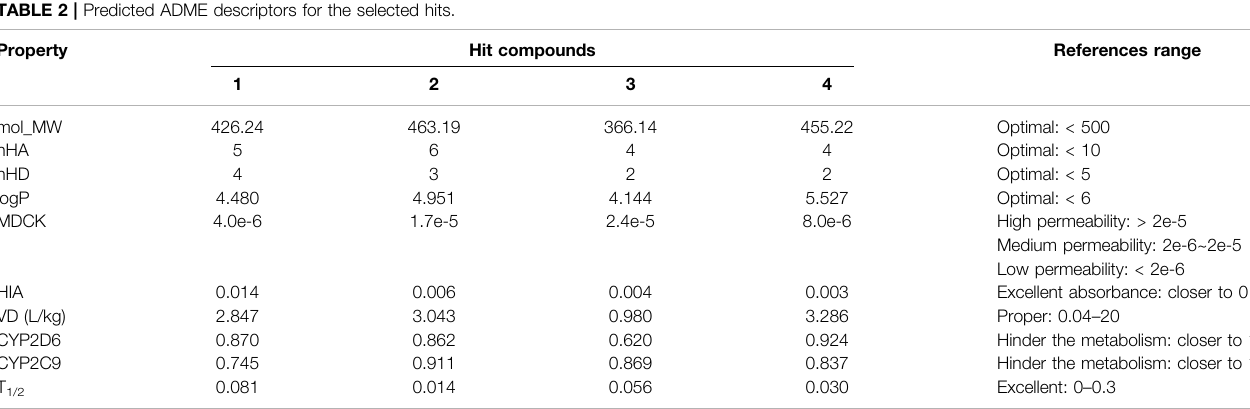
TABLE 2 | Predicted ADME descriptors for the selected